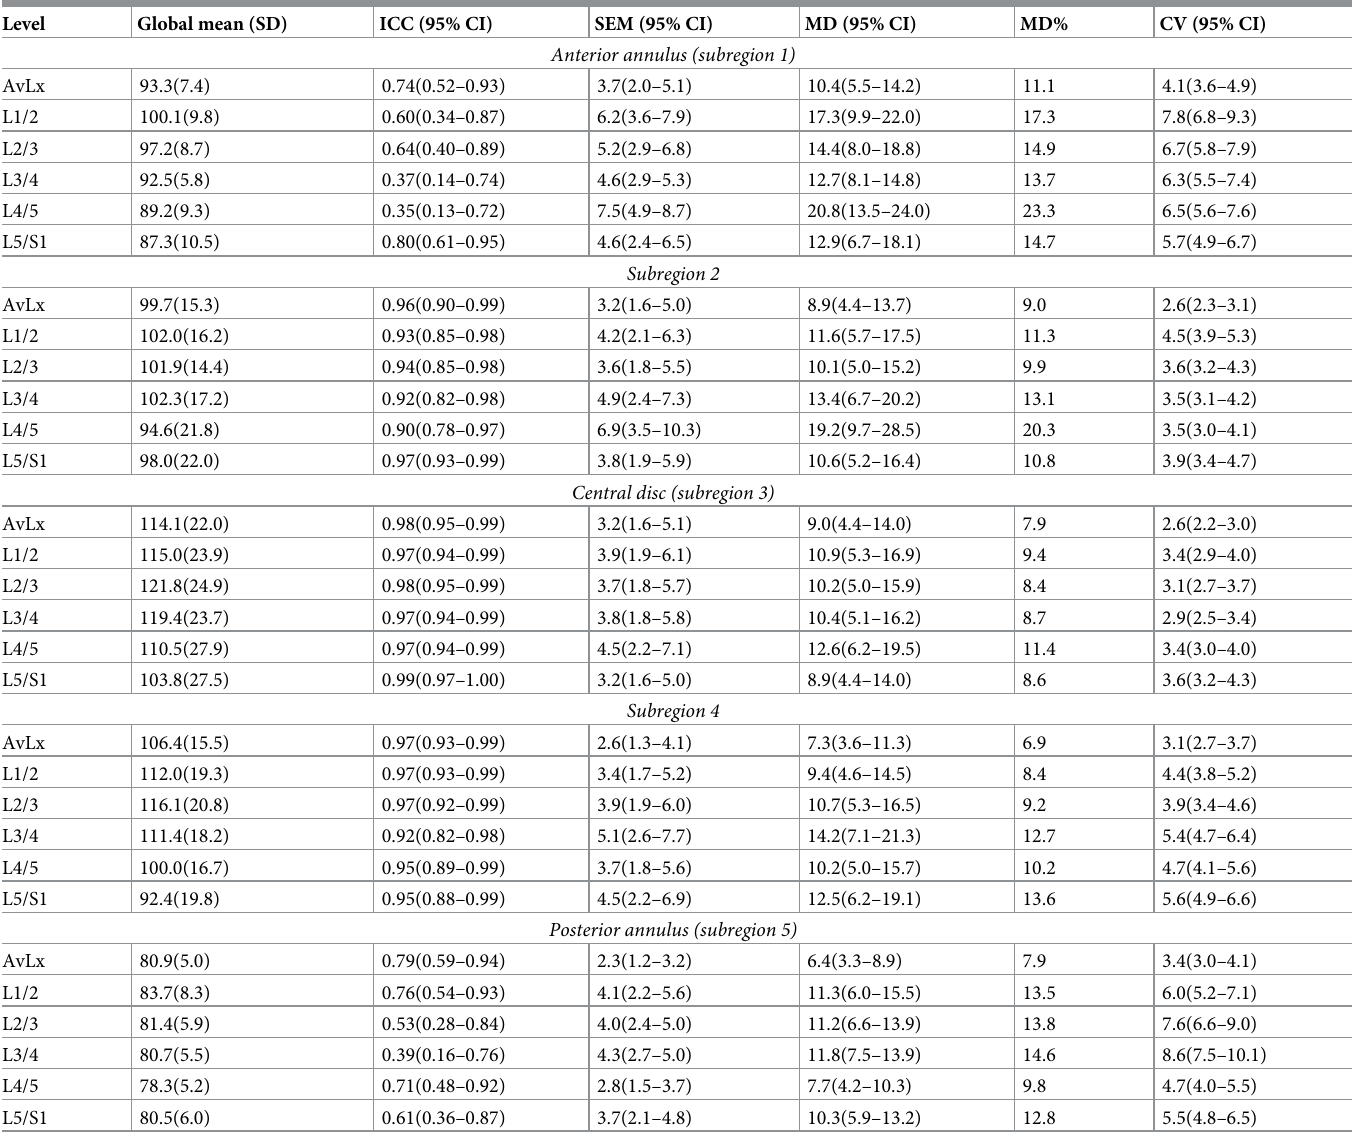
Table 2. Intra-discal subregion T 2 and their between-day